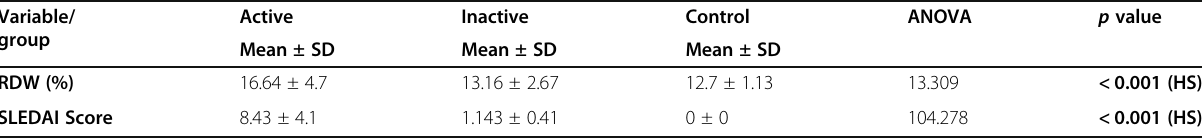
Table 3 Comparison between RDW and SLEDAI score with significant RDW % in the active group and SLEDAI score Variable/